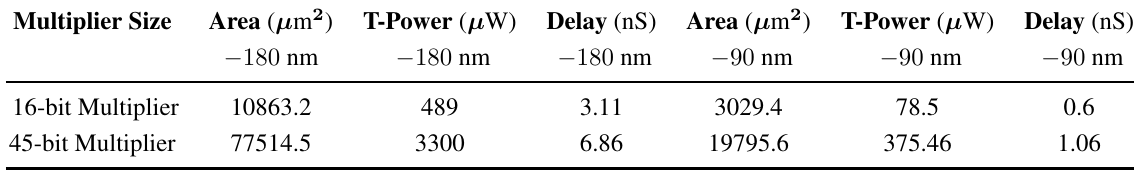
Table 2. Comparison of 16-bit versus 45-bit GF Multiplier